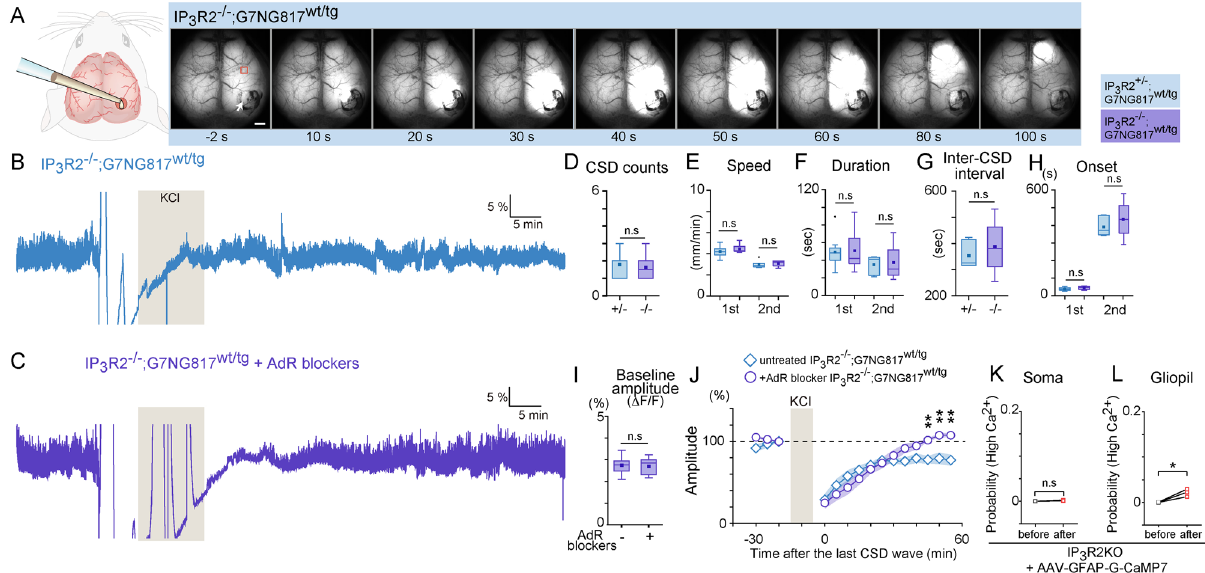
Figure 3. CSD propagation and neural activity recovery in IP 3 R2 KO mice. ( A ) Representative image of the time series of CSD propagation. Other than using IP 3 R2 −/− ;G7NG817 wt/tg double transgenic mouse as subjects, the experimental conditions are the same as in Fig. 1. Scale bar 1 mm. ( B ) Example trace of Ca 2+ activity of an ROI located ~ 2 mm anterior to the KCl application site (Black square indicated in A ). Note that neural activity does not recover completely within 50 min. ( C ) Similar Ca 2+ signal trace as ( B ). measured